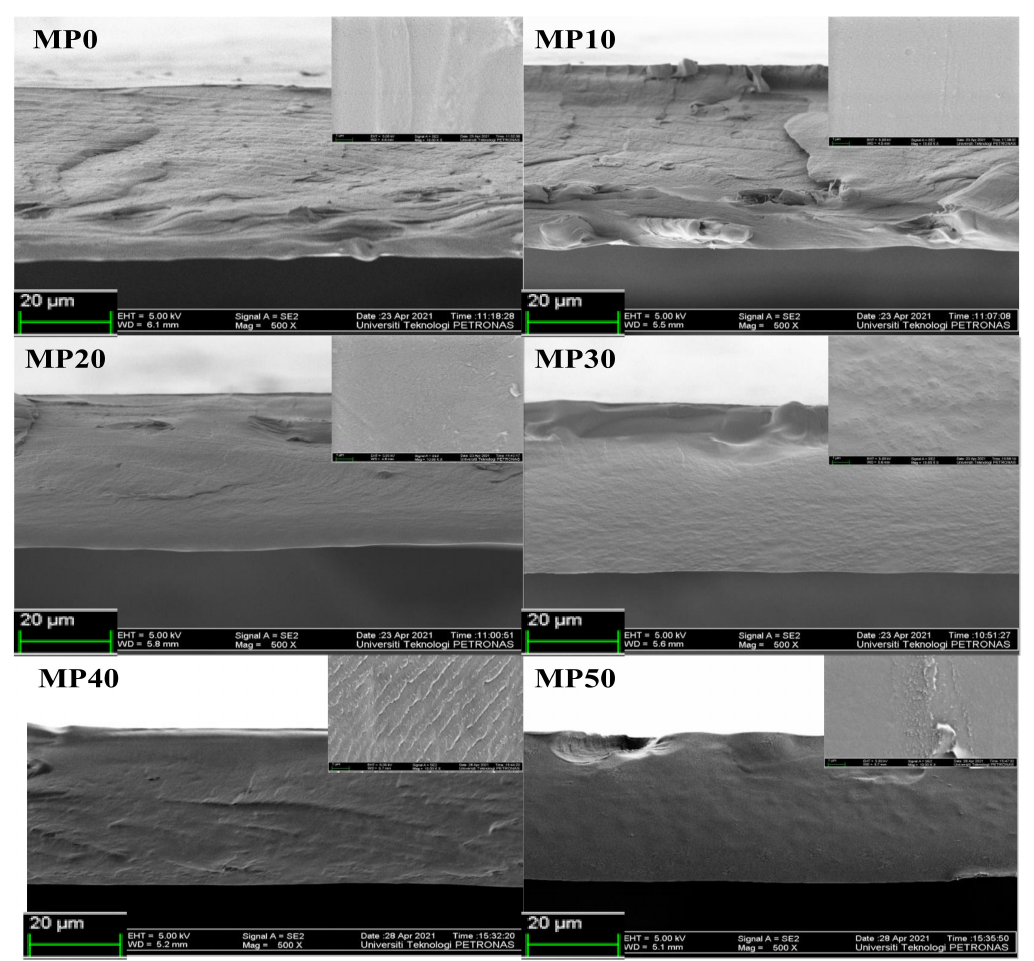
Figure 7. FESEM micrographs of MC/PVP polymer